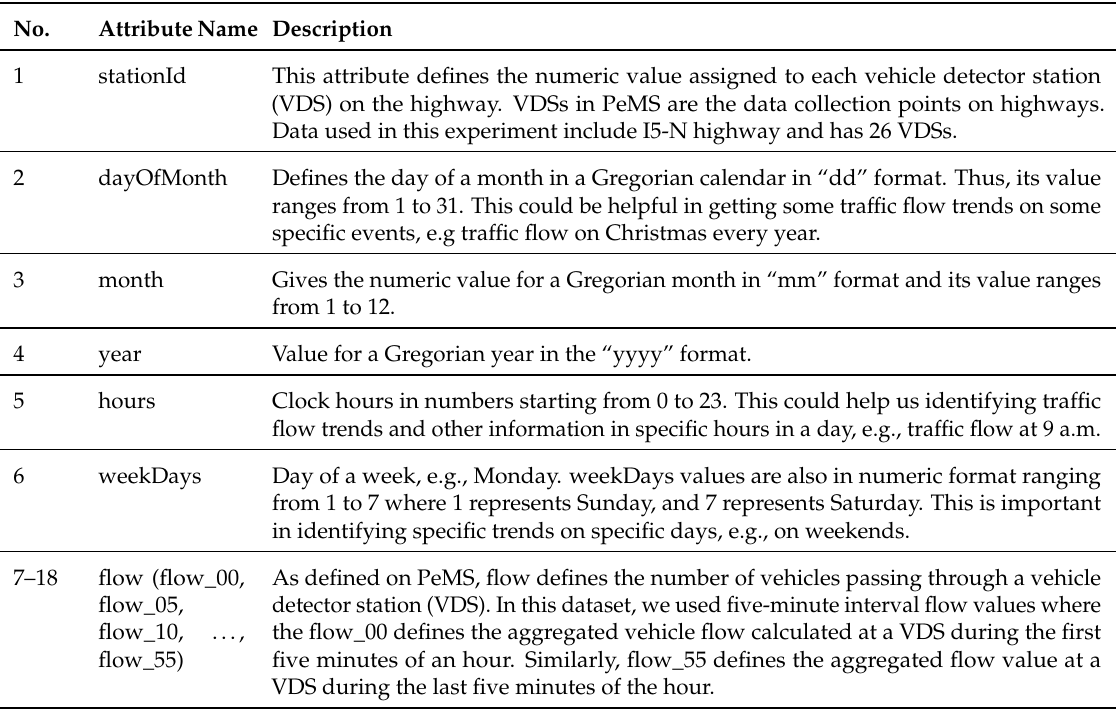
Table 2. Traffic flow: The dataset schema used as input to our DL